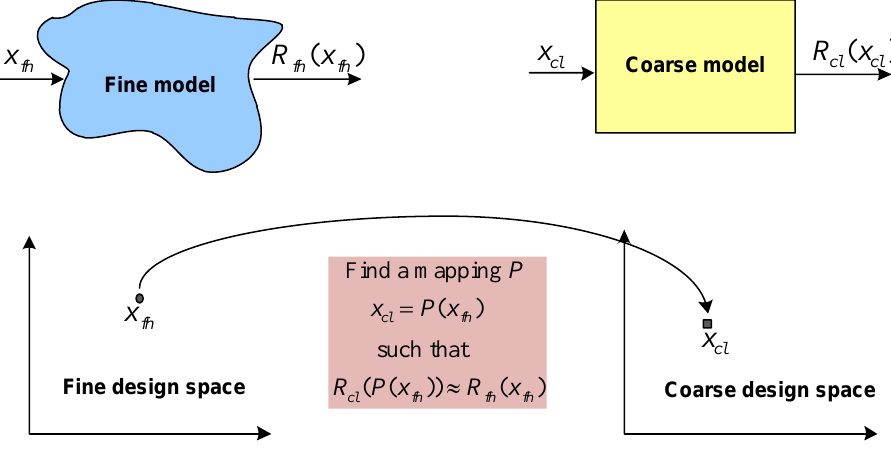
Figure 10. Framework of space mapping optimization method.